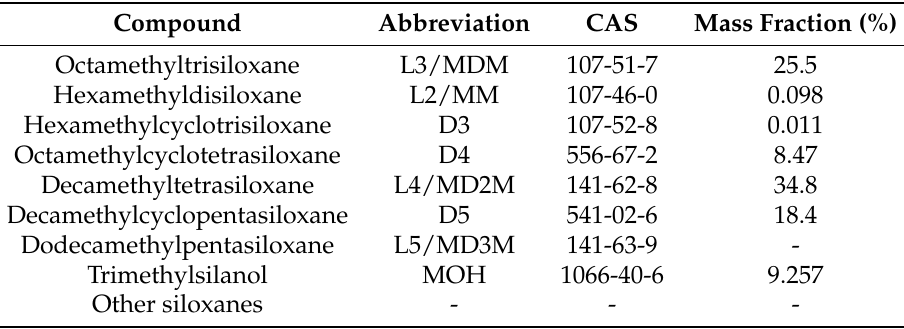
Table 8. HS-GC-MS analysis results of Experiment A, residue.